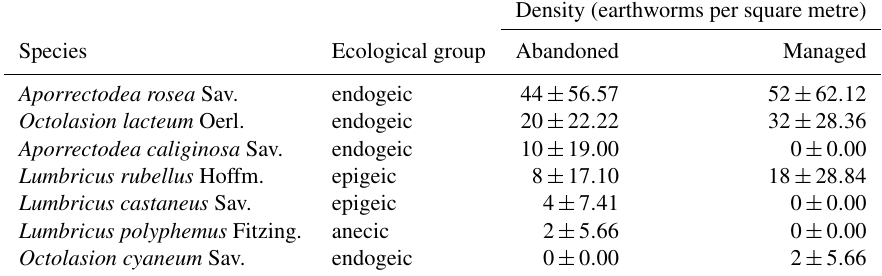
Table 2. Adult earthworm species found in abandoned and managed meadows with mean density of individuals per species in June and August. Values are means ± SD. Results do not include juvenile species with unclear identification.